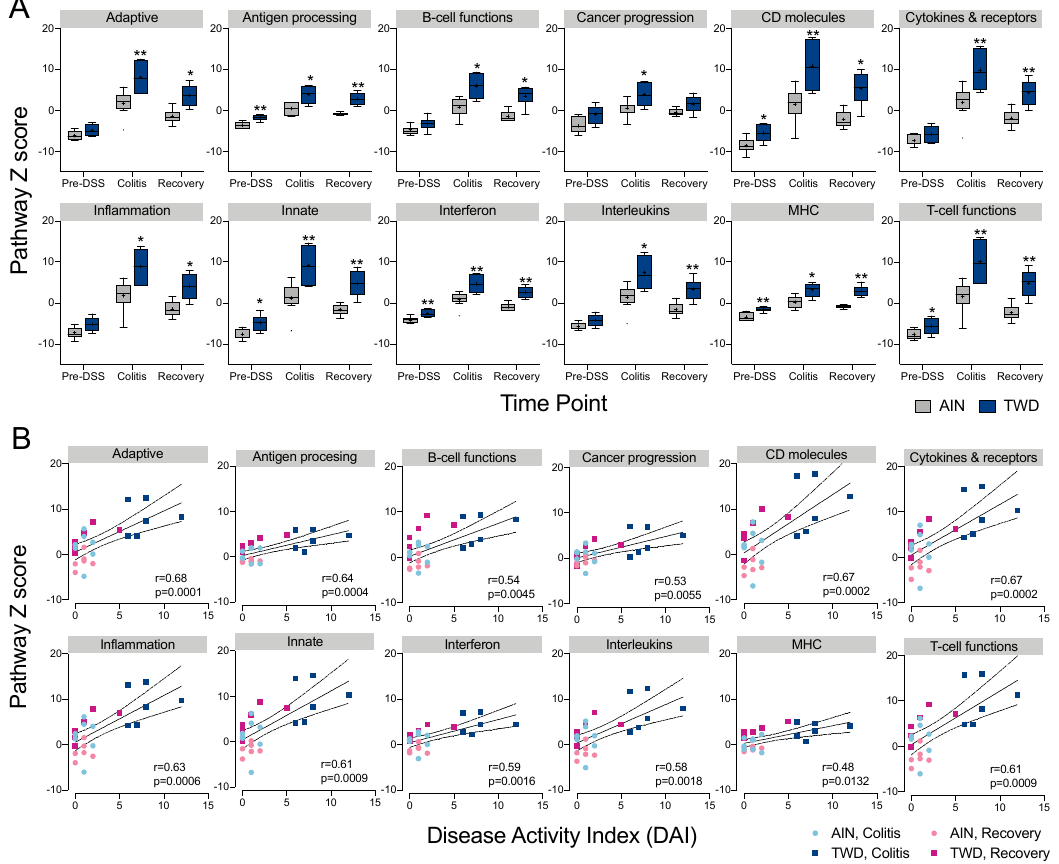
Figure 8. Pathway Z scores indicate broad scale changes in transcript abundance for genes associated multiple immune and cancer pathways that are also highly correlated with the colitis DAI. ( A ) Colon tissue gene expression pathway Z scores at Pre-DSS, colitis and recovery time points for mice fed AIN or TWD diets. Scores are shown as Tukey box plots ( n = 6 to 8) for selected immune and cancer pathways. * p < 0.05 and ** p < 0.01 compared to time point-matched AIN control as determined by the non-parametric Steel-Dwass test. ( B ) Correlation analyses of immune-associated pathways and colitis disease activity index (DAI) at colitis and recovery time points. Spearman correlation r and p values are indicated.